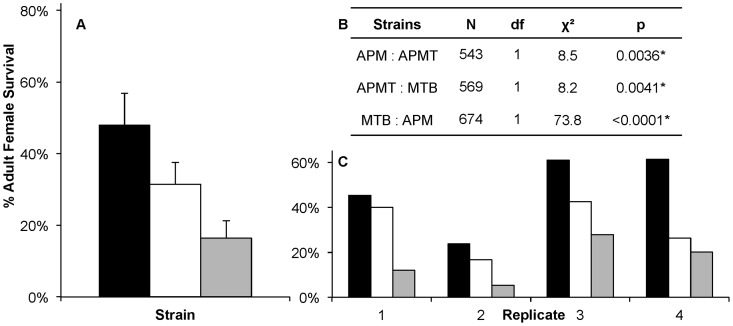
Survivorship of Ae. polynesiensis strains after a Brugia-infected blood meal.Mean survivorship of APM (black), APMT (white) and MTB (grey) ten days after feeding on a Brugia pahangi-infected blood meal. Contrast comparisons demonstrate significant differences in survivorship for each pair-wise comparison between strains. A) The mean survival of the four replicates. Error bars represent standard error. B) Contrast comparisons. C) The relationship between strains (APM>APMT>MTB) was consistent across all four replicates (GLM: χ2 = 6.27, df = 6, p = 0.39). For all tests, α = 0.05.